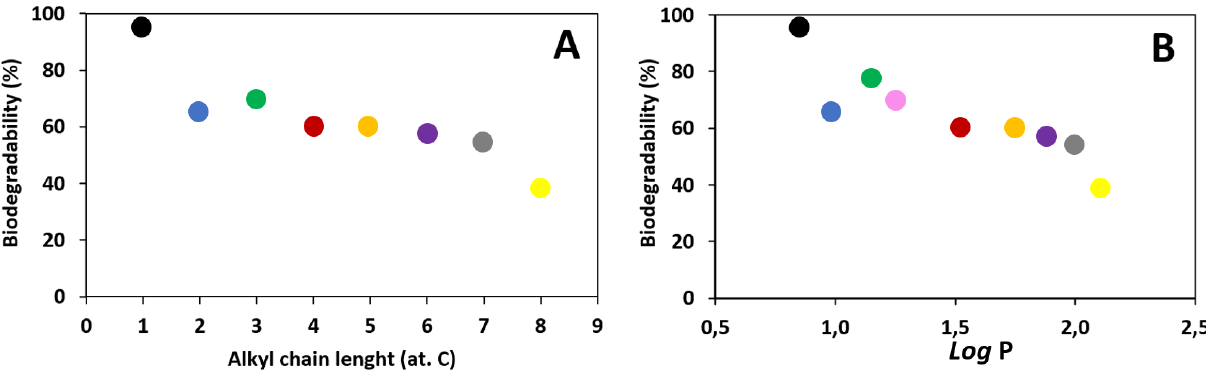
Figure 7. Dependence of biodegradability ( A ) on the alkyl chain length, ( B ) on the lipophilicity (expressed as log P): [ValOMe][IBU]—black dot, [ValOEt][IBU]—blue dot, [ValOPr][IBU]—green dot, [ValOiPr][IBU]—pink dot, [ValOBu][IBU]—red dot, [ValOAm][IBU]—orange dot, [ValOHex][IBU]—violet dot, [ValOHept][IBU]—grey dot, [ValOOct][IBU]—yellow dot.